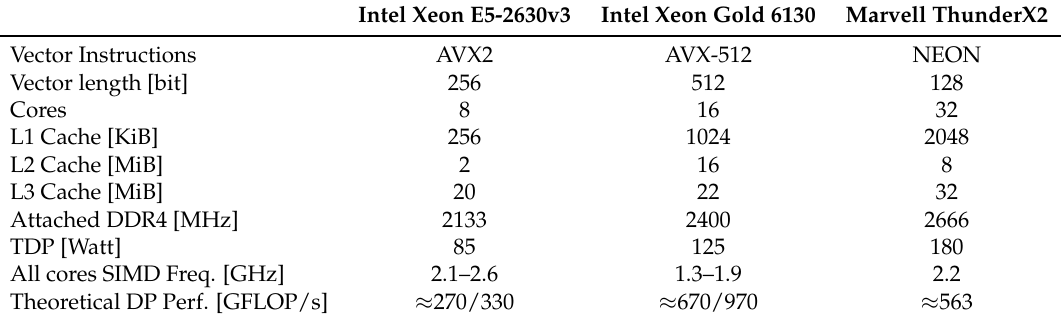
Table 1. Hardware details of the three different CPUs. Maximum performance computed taking into account the minimum and maximum clock frequency, when running vector instructions on all available